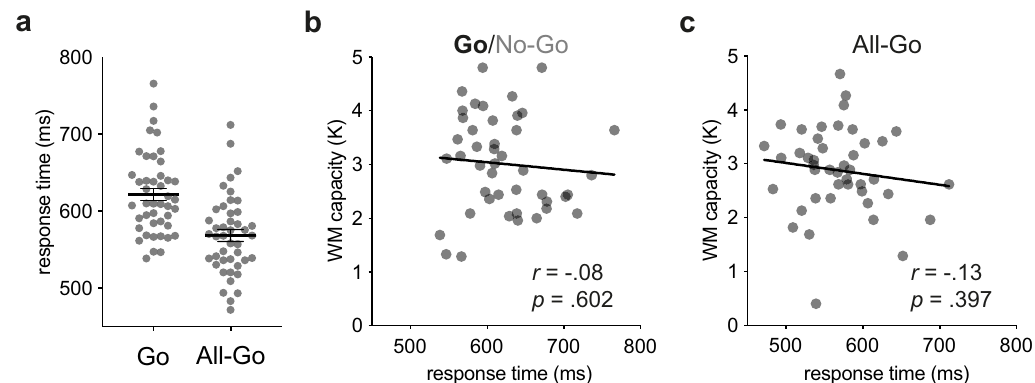
Fig 4. RT results from Experiments 1 and 2. The underlying data supporting this figure can be found at https://osf.io/4wdzq. ( a ) Mean RTs for correct singleton-present trials of Experiments 1 (Go trials) and 2 (All-Go trials). Each dot represents a participant’s mean RT, and each horizontal line with SEM bars shows the grand-averaged RT. ( b ) Bivariate plot with WM capacity in Experiment 1. ( c ) Bivariate plot with WM capacity in Experiment 2. RT, response time; WM, working memory.